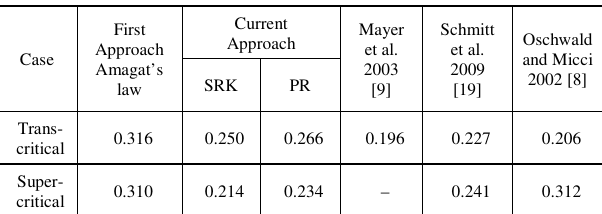
Table 2. Results of jet spreading